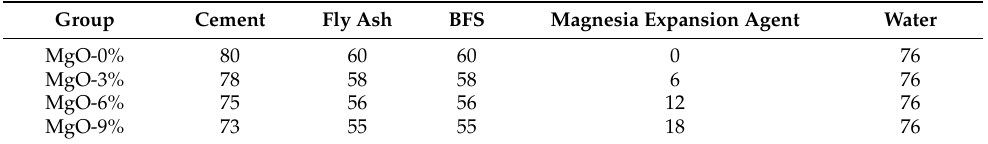
Table 2. The mixing proportion of the fresh cement paste (g).